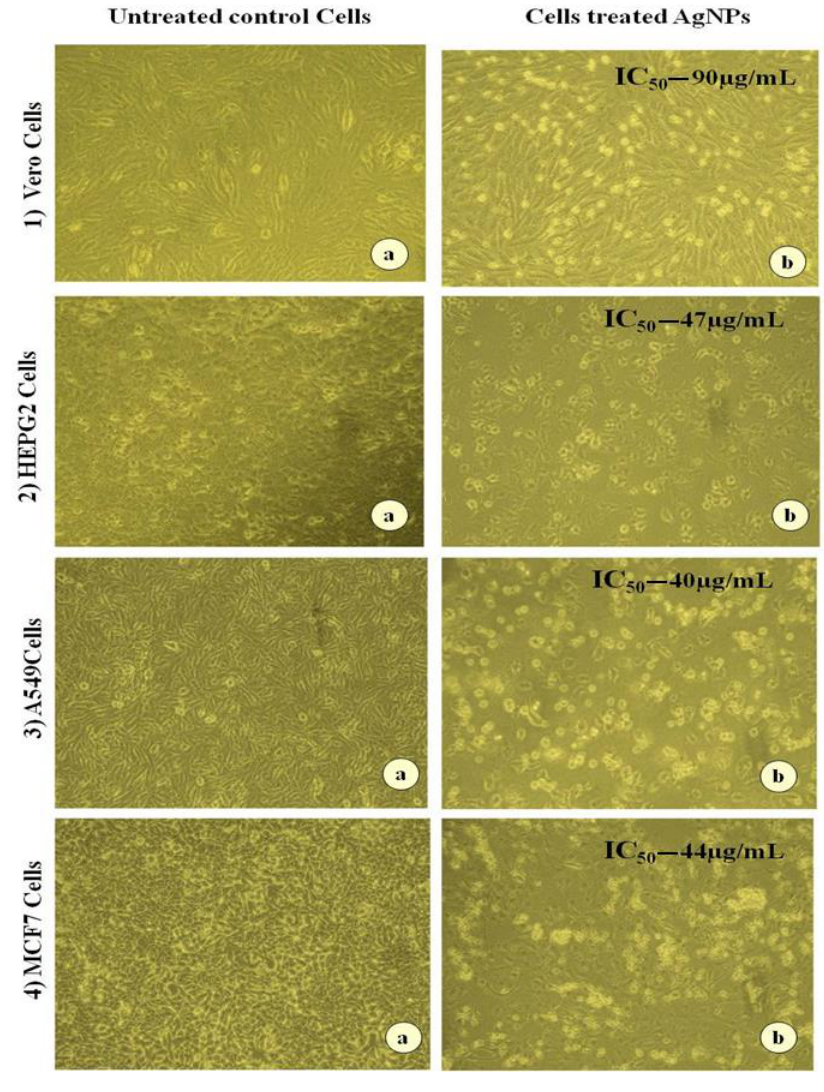
Figure 6. In vitro cytotoxic effect of AgNPs against normal Vero cells and cancerous cells, such as HepG2, A549 and MCF-7 cells, with an MTT assay. The untreated control ( a ) and NPs treatment ( b ) of 4 different cell lines were shown.